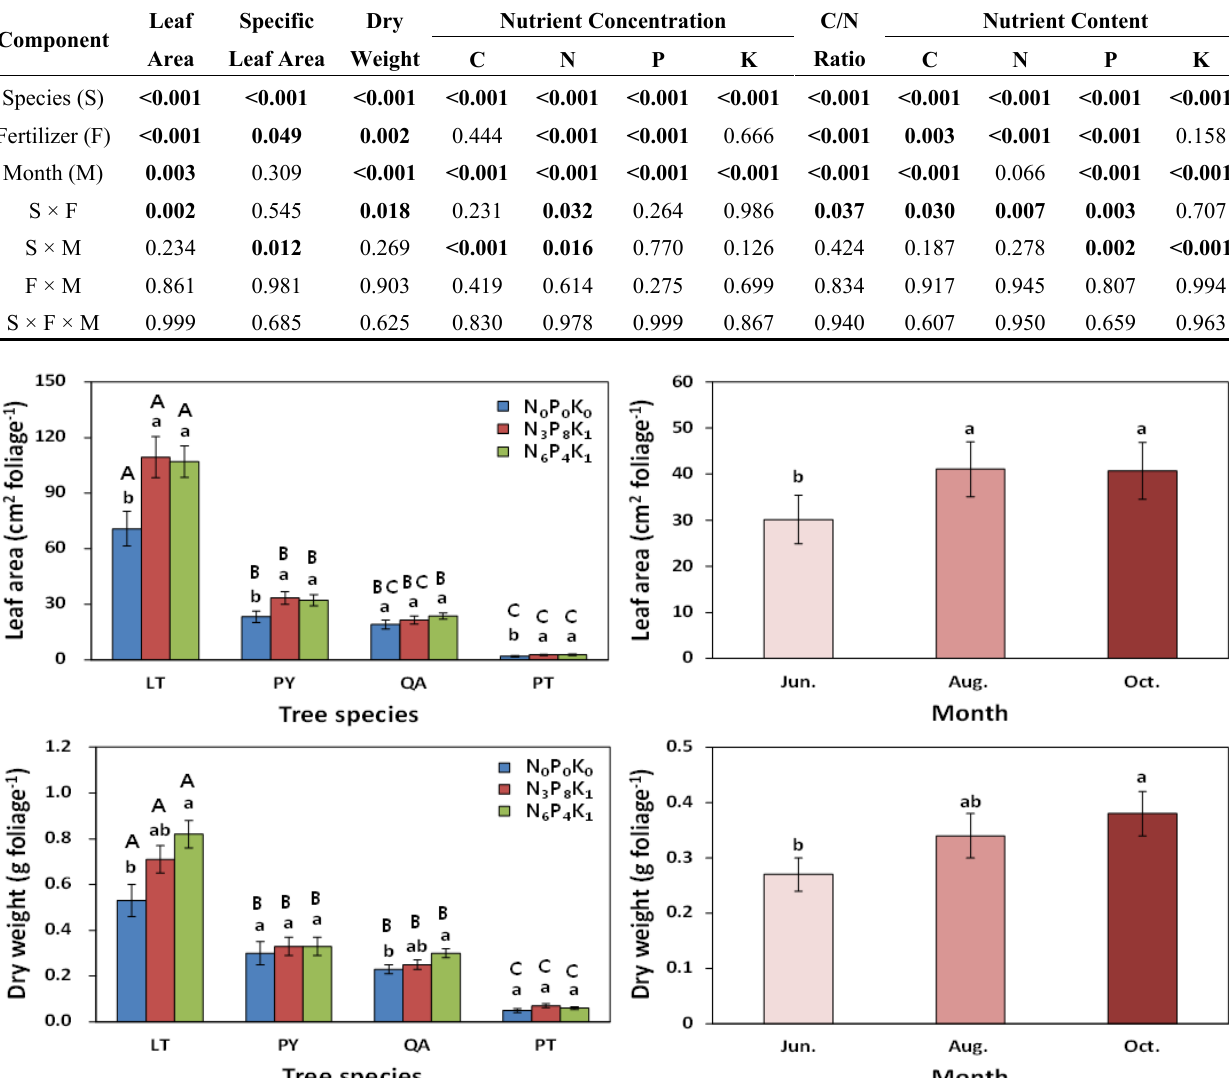
Table 3. P -value from results of three-way ANOVA on tree species, fertilization and sampling month on growth and nutrient responses of foliage from tree species planted in a fire-disturbed urban forest. Bold values denote significance at p < 0.05.